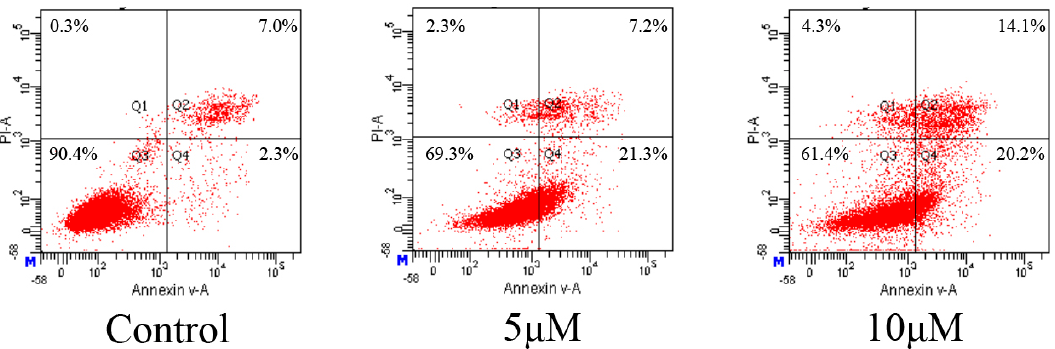
Figure 2. Apoptosis ratio detection of 4j by flow cytometry. Cells were treated with compound 4j for 48 h.